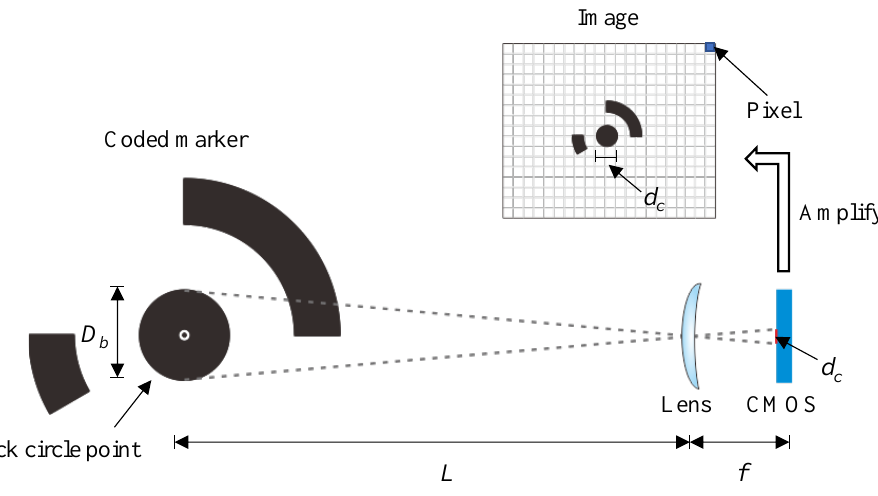
Figure 15. The basic principle of a smartphone camera.